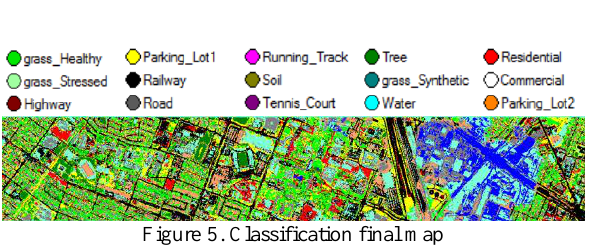
Figure 5. Classification final map